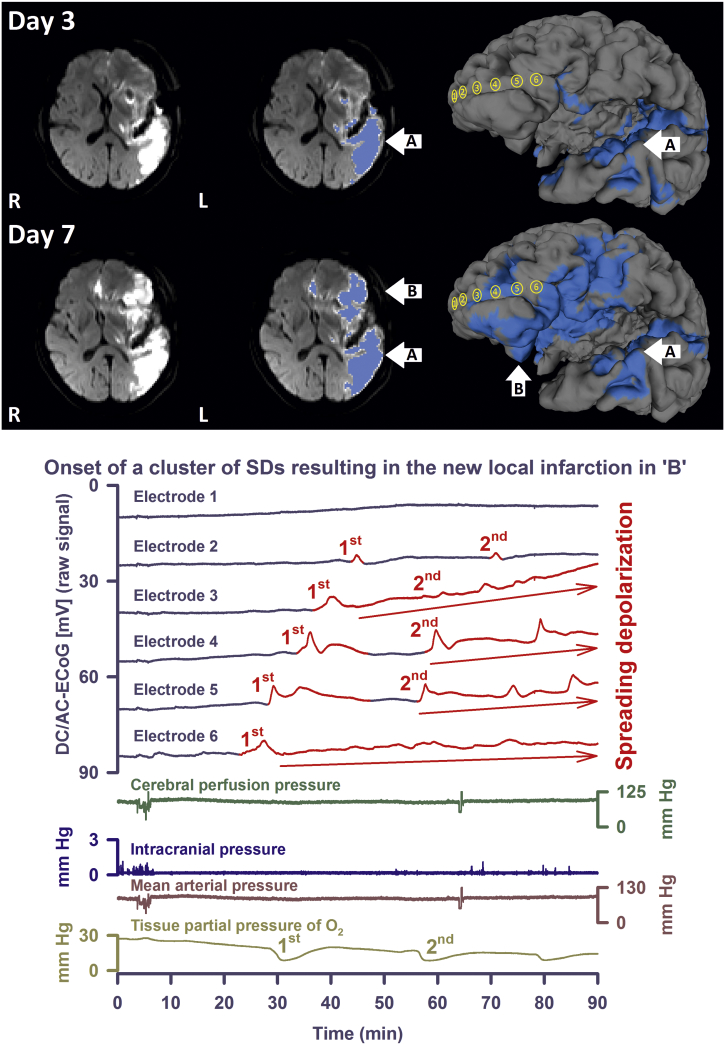
Development of a delayed ischemic infarct after aSAH in patient 3. Upper: Diffusion-weighted MRI (DWI) shows an infarct in the posterior territory of the left middle cerebral artery (MCA) on day 3 (upper left image). On day 7, a new delayed ischemic infarct is visualized in the left anterior MCA territory including the recording area (lower left image). In the middle images, the ischemic lesions are marked in blue (A = early and B = delayed infarct). The blue regions of interest originate from DWI (b = 1000) images superimposed onto geometrically discretized (triangular mesh) whole brain taken as MPRAGE sequence from the same subject. The region of interest threshold was set at 2/3 of the maximum value. On the right side, the reconstructed brain surfaces are depicted. Also on the reconstructed cortical surfaces, the DWI lesions are marked in blue. The subdural recording strip was projected from a CT onto the cortical surface (yellow electrodes 1 to 6). Note that, apart from electrode 1, all electrodes overlay the new delayed infarct. Lower: DC/AC-ECoG recordings of the two initial SDs of a cluster that occurred on day 4 after aSAH between the two MRIs of days 3 and 7. Based on our knowledge of the electrophysiological signature of stroke in animal experiments, the cluster was presumably the correlate of the new infarct. Whereas the simulation found possible trajectories for the first SD, it failed to do so for the second one. This provides another example illustrating that the simulation did not find possible SD trajectories in a significantly higher proportion of isoelectric SDs with DC shift durations > 4 min compared with the remaining SDs. Also note that the SDs are superimposed on a negative ultraslow potential (red arrows) as explained recently (Dreier et al., 2017). Traces are similar to Fig. 5.